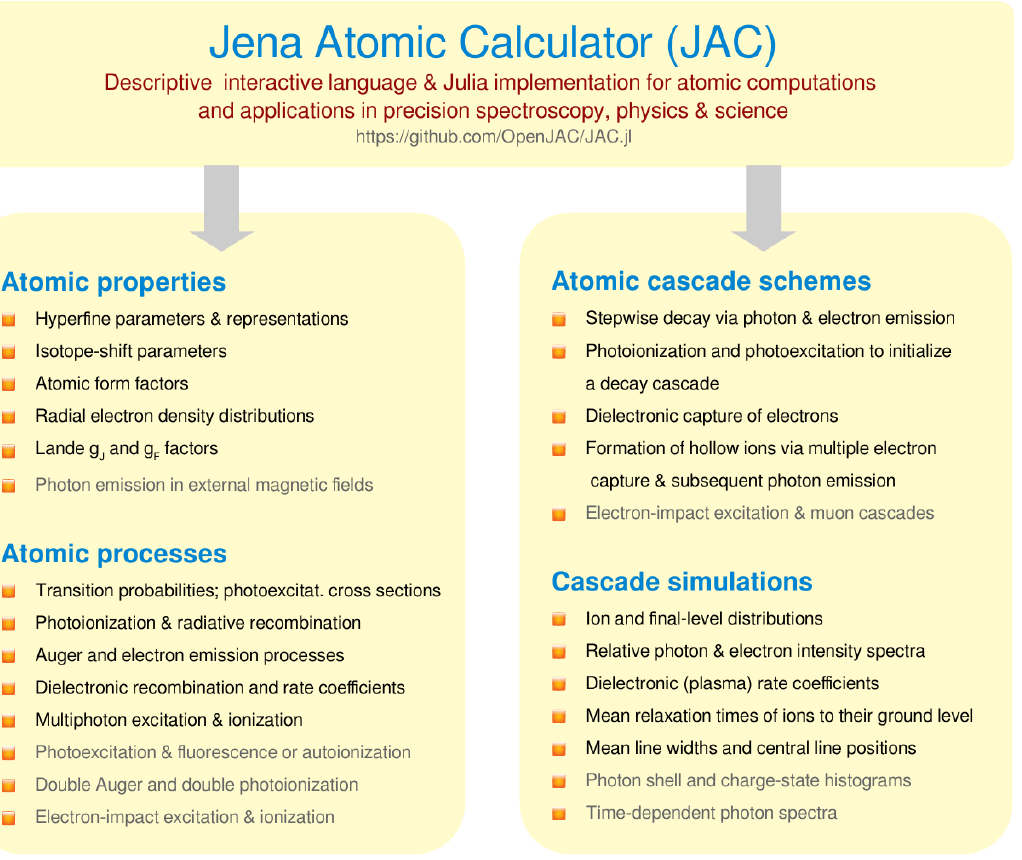
Figure 2. Selected applications of the J AC toolbox that help calculate atomic properties, processes and cascades. See Refs. [16,30] for a detailed account of the various features of this